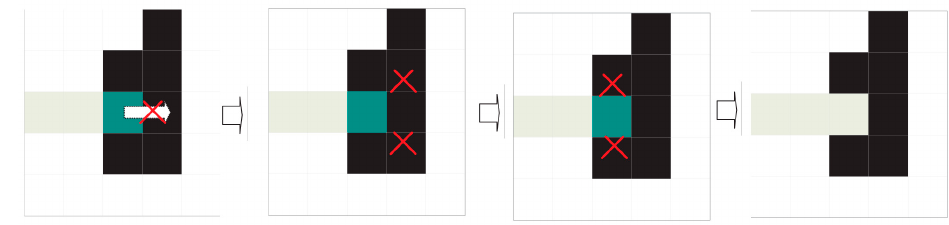
Figure 16. MITOSIS: An agent disappears (“dies”) without issue if it finds no alternative. The divider does not have offspring.